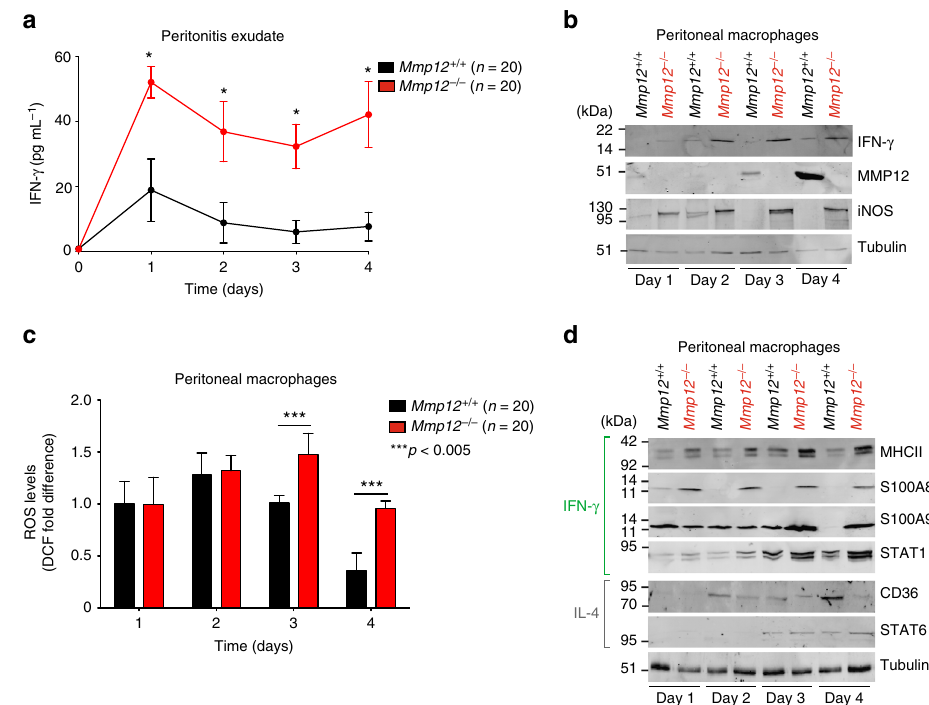
Fig. 3 MMP12 decreases IFN- γ -activated macrophage markers in acute peritonitis. a ELISA of IFN- γ protein levels in peritoneal exudate of male Mmp12 + / + B10.RIII ( n = 20) and Mmp12 – / – B10.RIII ( n = 20) mice at days 0 – 4 after induction of peritonitis ( n = 4 for each genotype for each time point, N = 2) expressed as the mean ± s.d. There was no IFN- γ quanti fi ed in healthy peritoneum in the absence of in fl ammation on day 0. Statistical signi fi cance was determined by two-tailed unpaired Student ’ s t -test: * p < 0.05. b 10% SDS-PAGE western blot analysis of IFN- γ , MMP12, and iNOS proteins in primary peritoneal macrophages harvested daily from Mmp12 + / + ( n = 20) and Mmp12 – / – ( n = 20) B10.RIII mice ( N = 2). Tubulin, loading control. c Cellular ROS levels in primary peritoneal macrophages were quanti fi ed by calculating the mean fl uorescence intensity after treatment with 2,-7-dichloro fl uorescein diacetate (DCF) ( n = 20 for each genotype, n = 4 for each time point, N = 2). Data were normalized to day 1 Mmp12 + / + B10.RIII macrophages and expressed as fold differences. Error bars, s.d. Statistical signi fi cance was determined by a two-tailed unpaired Student ’ s t -test: *** p < 0.005. d 10% SDS- PAGE western blot analysis of markers characteristic for macrophage activation by IFN- γ (MHCII, S100A8, and S100A9) and STAT1, or by IL-4 (CD36) and STAT6 in Mmp12 + / + and Mmp12 – / – B10.RIII mouse macrophages harvested daily ( n = 20 for each genotype, n = 4 for each time point, N = 2). Tubulin, loading control. Molecular weight marker positions in all blots are as